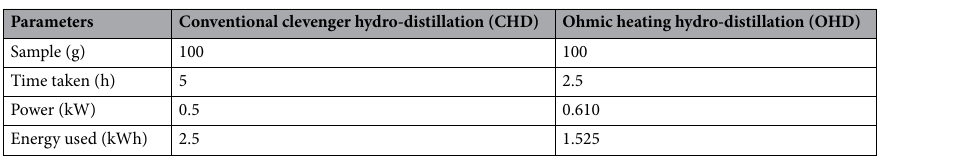
Table 2. Comparison of conventional clevenger hydro distillation (CHD) and ohmic-heating hydro distillation (OHD) processes.